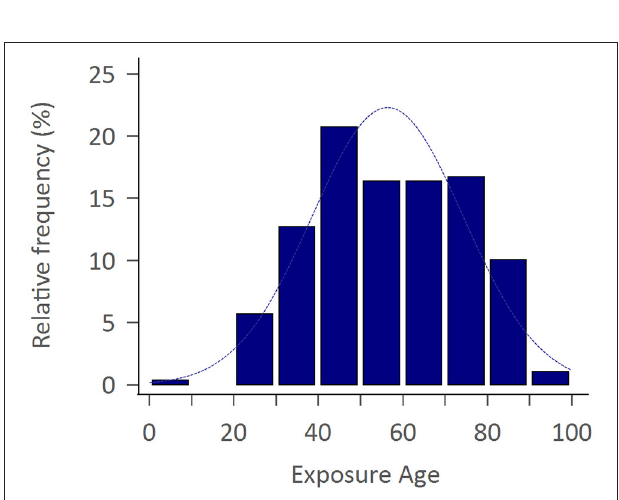
FIGURE 2 | Exposure age